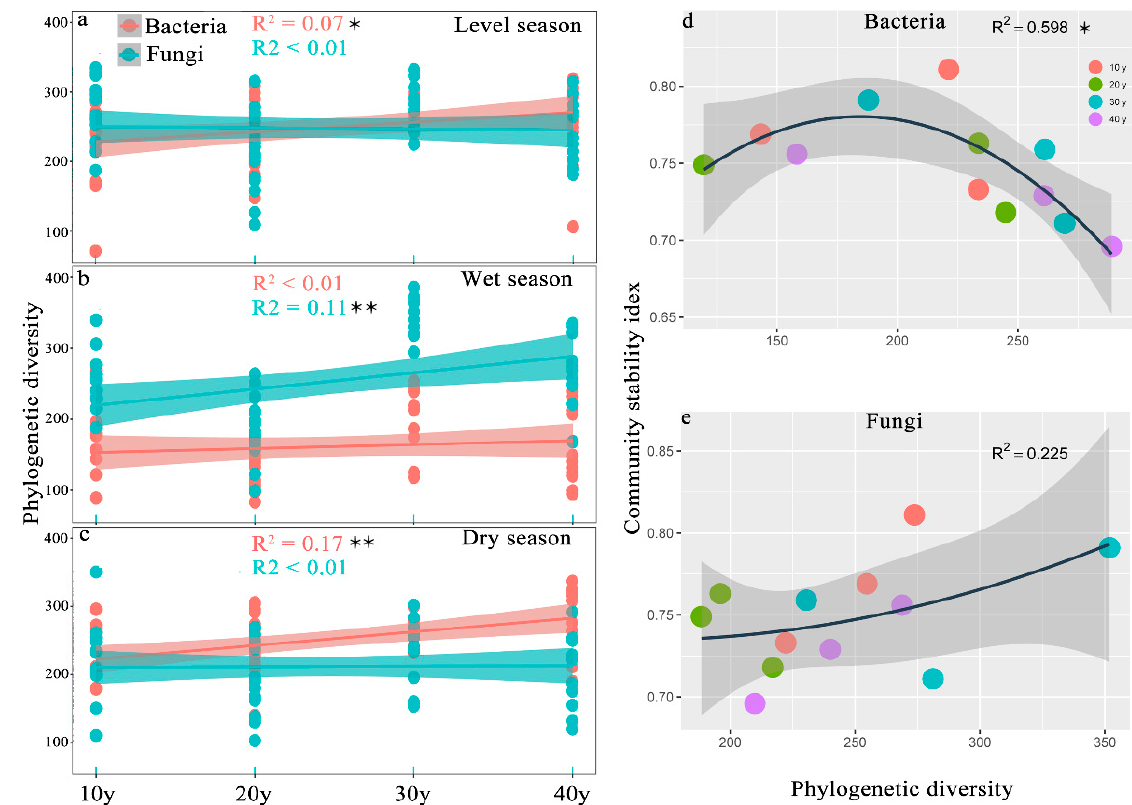
Figure 1. ( a – c ) Linear relationship between the PD index and the recovery times (significance is indicated by * p < 0.05, ** p < 0.01, n = 56). ( d , e ) Relationship between assemblage stability and the PD index. (R 2 represents the correlation coefficient, and significance is indicated by * p < 0.05, n = 12).